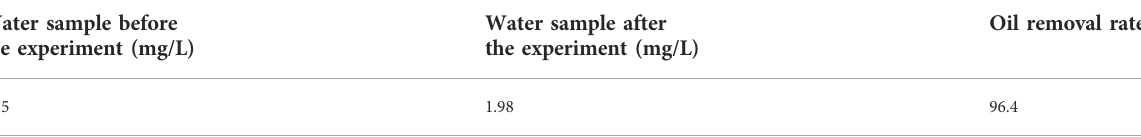
TABLE 5 Results of the oil – water separation experiment.